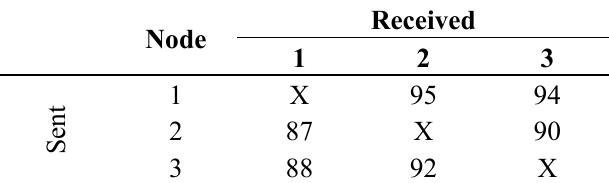
Table 8. Node percentage in dynamic test.